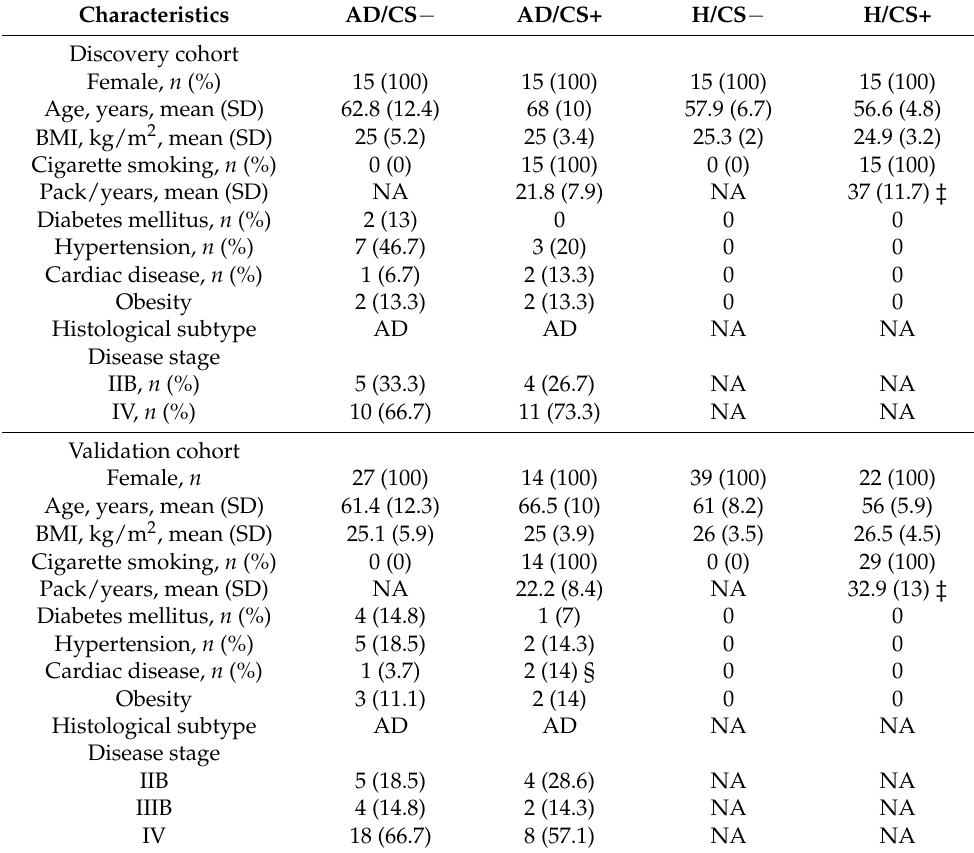
Table 1. Demographic and clinical characteristics of AD and healthy participants according to their cigarette-smoking